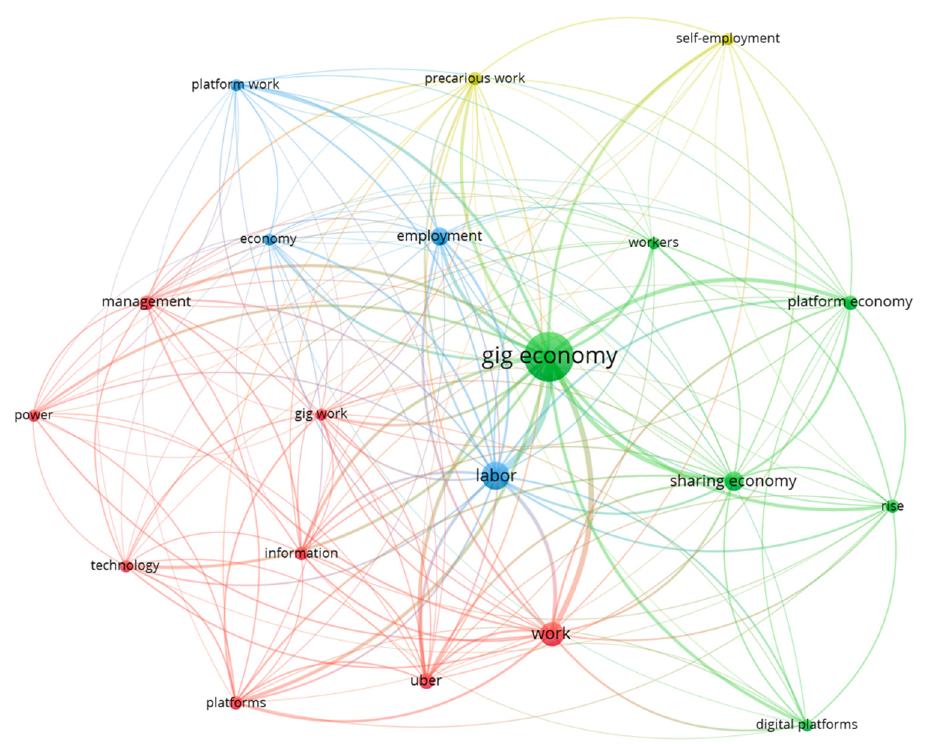
Figure 11. Author keyword co-occurrence.